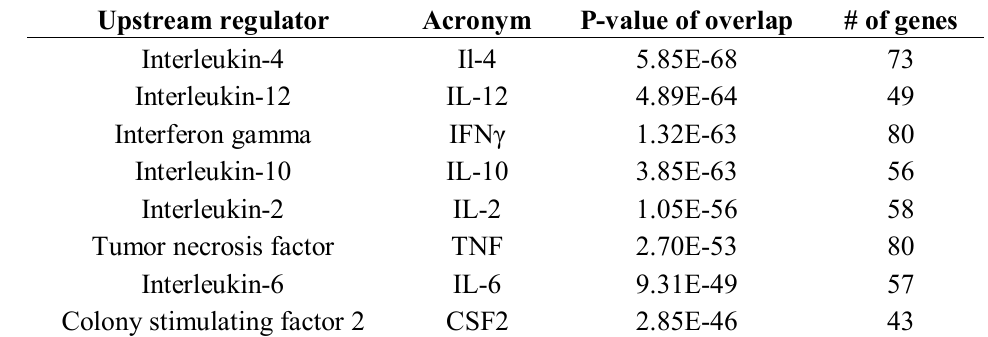
Table 2. Major upstream regulators of genes implicated in prion pathogenesis (Table 1), as determined by Ingenuity pathway analysis IPA (Ingenuity® Systems,